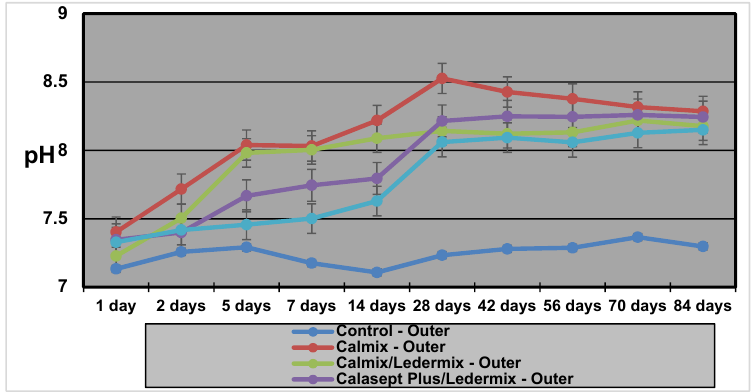
Figure 2. The pH values in the outer dentine with the various medicaments over 12